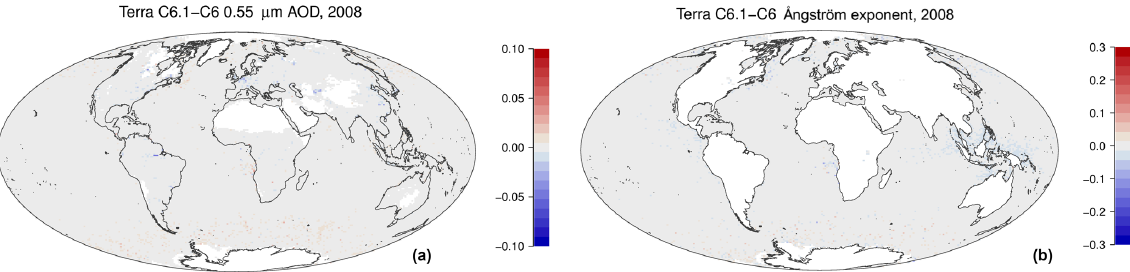
Figure 14. Differences between the C6.1 and C6 MOD04 (Terra) product for AOD (a) and AE (b) . Note that the color scales are identical to those in Figs. 3b and